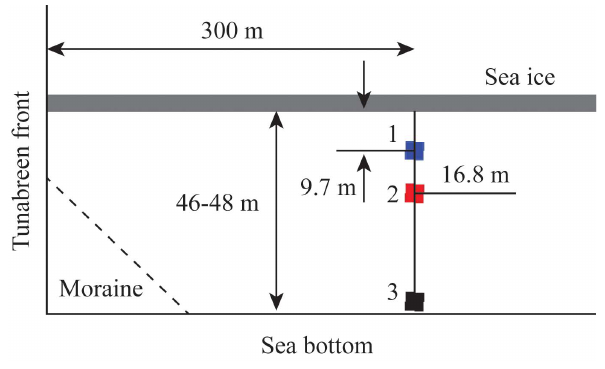
Fig. 3. Scheme of the deployment of pressure recorders SBE 39 (1 and 2) and SBE-37